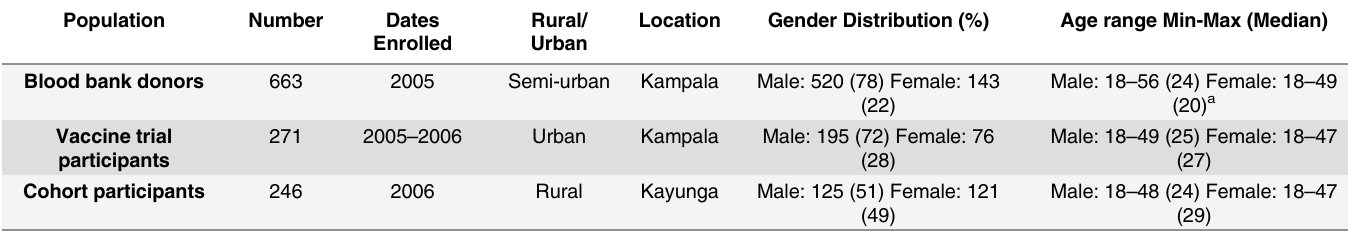
Table 1. Population demographics.